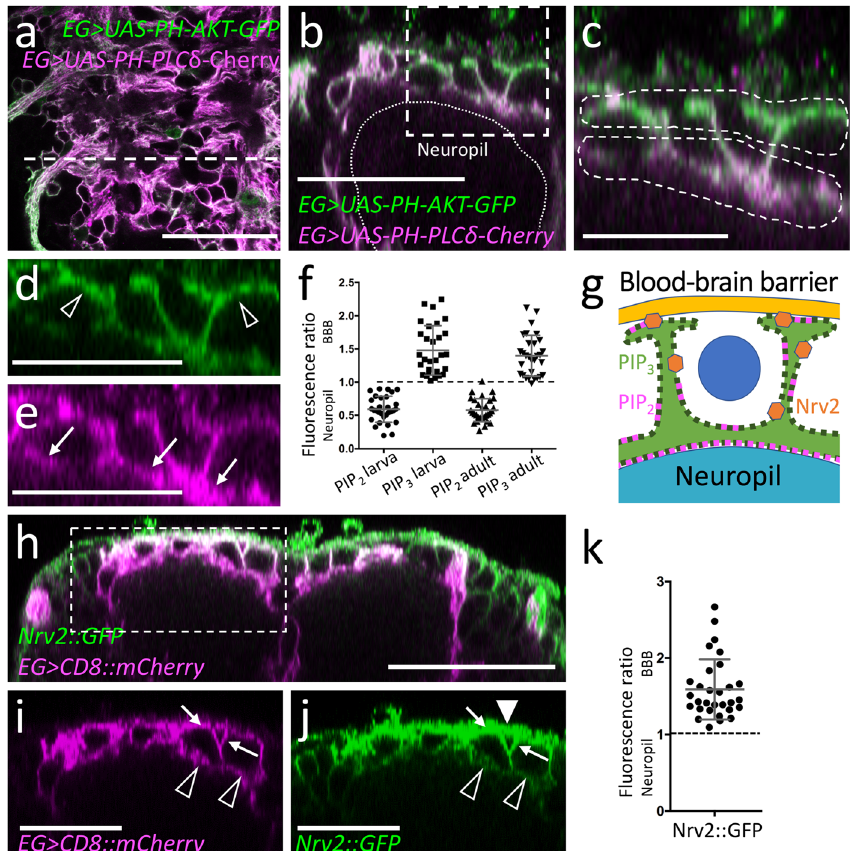
Fig. 6 Ensheathing glial cells show polarized plasma membrane domains. Representative images are shown. a Projection of a confocal stack of a third instar larval ventral nerve cord coexpressing PH-AKT-GFP and PH-PLC δ -mCherry in ensheathing glial cells (EG) [ 83E12-Gal4, UAS-PH-AKT-GFP, UAS - PH- PLC δ -mCherry ]. The dashed white line indicates the position of the orthogonal section shown in ( b ). b Orthogonal section showing the dorsal aspect of the neuropil. The boxed area is shown in higher magni fi cation in ( c – e ). The dashed areas were subsequently used for quanti fi cation of GFP and mCherry localization. f Quanti fi cation of GFP/mCherry distribution in larval and adult ensheathing glia. The ratio of red (PLC δ -mCherry shown in magenta) and green (PH-AKT-GFP) fl uorescent pixels of the areas indicated in ( c ) is plotted. The mean and standard deviation is shown. g Schematic view of a dorsal ensheathing glial cell. The neuropil facing domain is characterized by a high PIP 2 content, whereas PIP 3 is concentrated on the baso-lateral domain, where Nrv2 is predominantly localized, too. The blue dot indicates the position of a neuron. h Coexpression of Nrv2::GFP and 83E12-Gal4, UAS-mCherry in the ventral nerve cord of third instar larva. The boxed area is shown in higher magni fi cation in ( i , j ). Note the preferential localization of Nrv2 at the basolateral cell domain of the ensheathing glia (arrows). Only little Nrv2 is found at the apical domain (open arrow head). Additional expression of Nrv2 is seen in the blood – brain barrier ( fi lled arrowhead). k Quanti fi cation of polarized Nrv2::GFP localization. The mean and standard deviation is shown. Scale bars in a , b , h : 50 µ m; in b – e , i , j : 25 µ m. Source data are provided as a Source Data fi